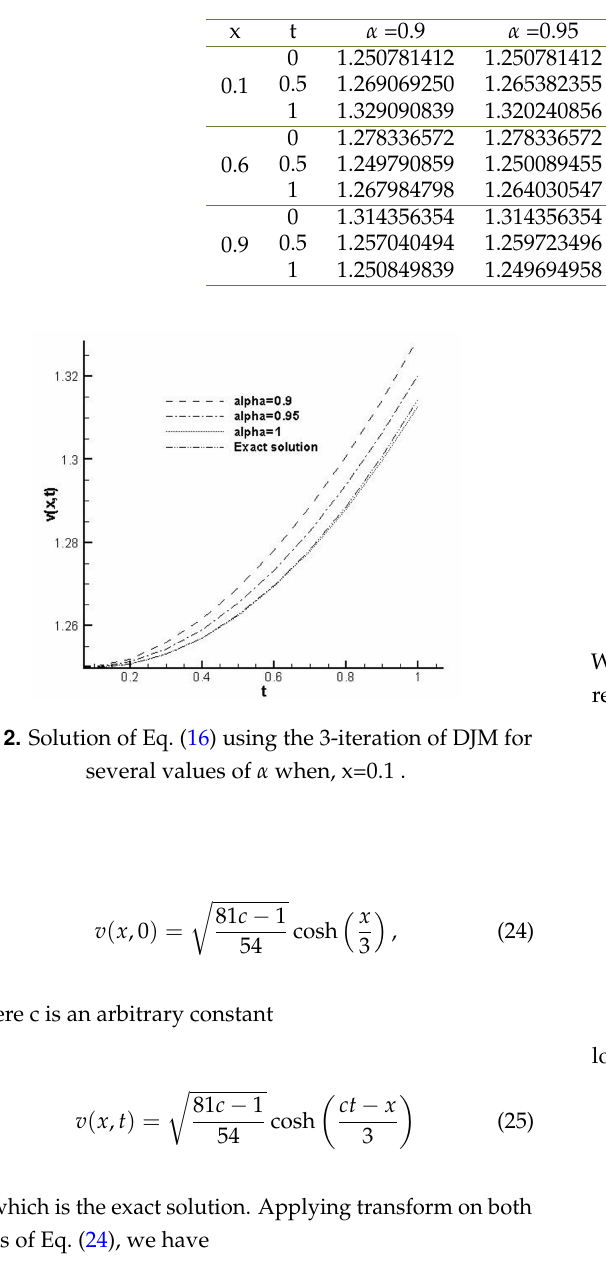
Table 1. Solution of Eq. (16) using DJM for different values of α .